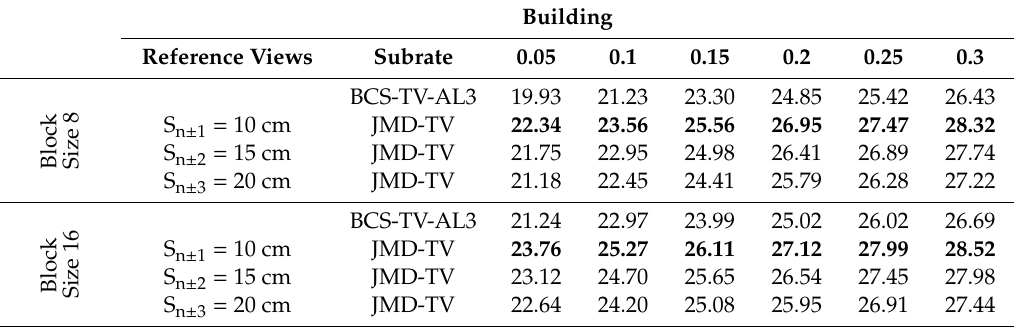
Figure 13 . Visual quality comparison of images encoded using independent BCS-TV-AL3 and Figure 13. Visual quality comparison of images encoded using independent BCS-TV-AL3 and JMD-TV JMD-TV at subrates 0.2, block size 16 × 16, and visual nodes separation of 15 cm . at subrates 0.2, block size 16 × 16, and visual nodes separation of 15 cm. Table 5. Performance (PSNR (dB)) comparison of using the JMD compression scheme with di ff erent camera separations, block sizes, and